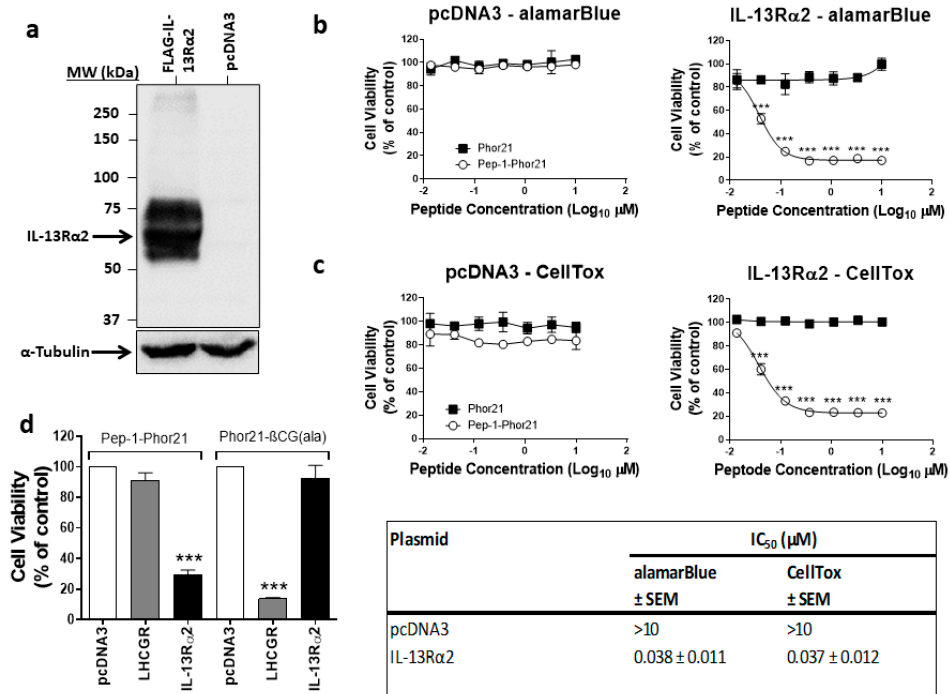
Figure 2. Pep-1-Phor21 specificity in targeting IL-13R α 2-expressing cells. ( a ) Western blot analysis of IL-13R α 2 protein expression in HEK293 cells. The lysates of HEK293 cells transfected with IL-13R α 2 plasmid or an empty plasmid (pcDNA3) were separated via SDS-PAGE, transferred onto the PVDF membrane and probed using an anti-IL-13R α 2 antibody. The lysates were also probed with an anti- α -Tubulin antibody to ensure equal loading. HEK293 cells transfected with pcDNA3 or IL-13R α 2 were incubated with 0 - 10 µM (a 3-fold serial dilution starting with 10 µM (10 µM, 3.3 µM, 1.1 µM, 0.37 µM, 0.12 µM, 0.04 µM, 0.01 µM) was used) of Pep-1-Phor21 ( ○ ) or Phor21( ■ ) for 3 h and their cytotoxicity was measured using alamarBlue ( b ) and CellTox ( c ) assays. ( d ) The specificity of the cytotoxicity effect of Pep-1-Phor21 on HEK293 cells expressing IL-13R α 2. HEK293 cells expressing nothing or IL-13R α 2 or LHCGR were incubated with 0.5 µM Pep-1-Phor21 or Phor21- β CG (ala) for 3 h and their cytotoxicity was measured via CellTox assay. The data represent means ± SEM (error bars represent SEM) of three independent experiments (*** p < 0.001).